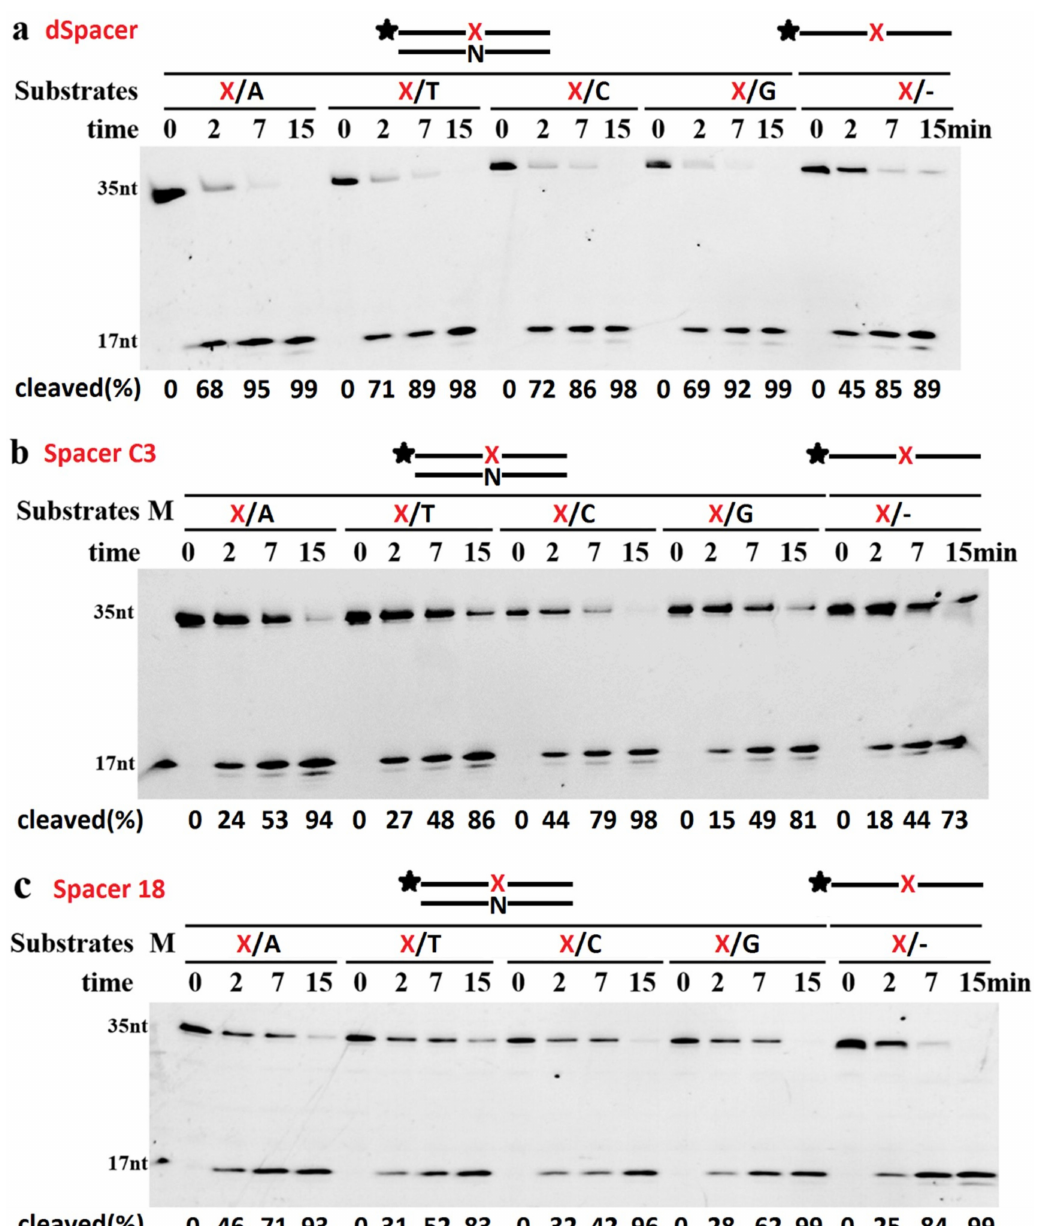
Figure 5. Effect of the base opposite AP site on dsDNA cleavage. TeuendoIV (5 nM) was incubated with 100 nM ssDNA or dsDNAs opposite each of four bases at 55 ◦ C for the indicated time. The Spacers are ( a ) dSpacer, ( b ) Spacer C3, and ( c ) Spacer 18. Uppercase letter M denotes oligonucleotides marker. The cleavage percentages of substrates are listed at the bottom of each